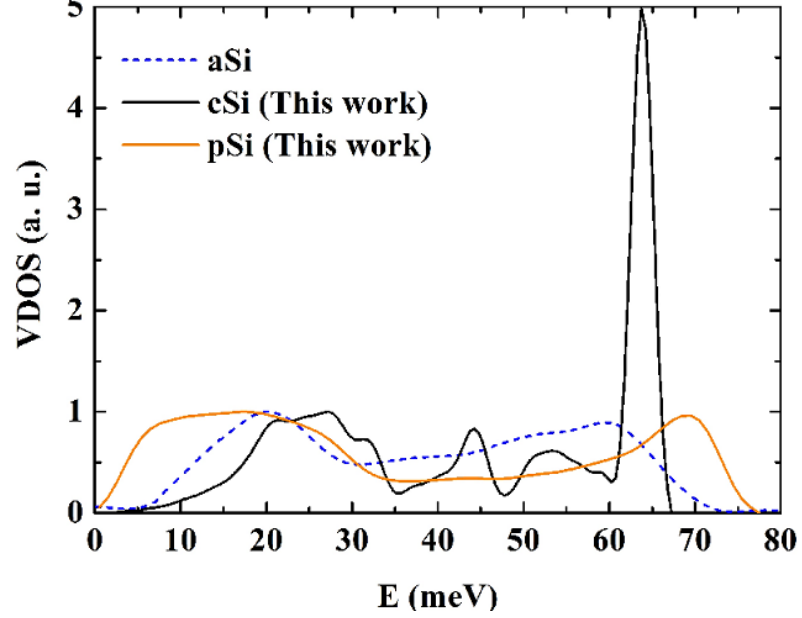
Figure 15. Vibrational densities of states (VDOS) for crystalline, c-Si, amorphous, a-Si [50], and porous, p-Si, silicon calculated using the Tersoff potential. The height of the optical crystalline peak masks the detailed structure of the porous and the amorphous samples. The units on the vertical axis are arbitrary.